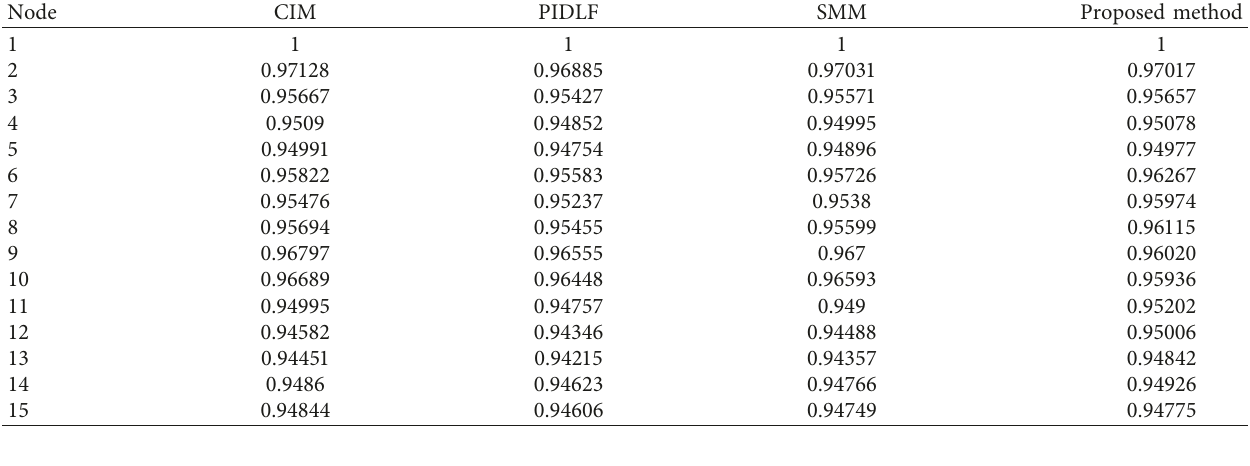
Table 5: Results for IEEE 15-bus system.